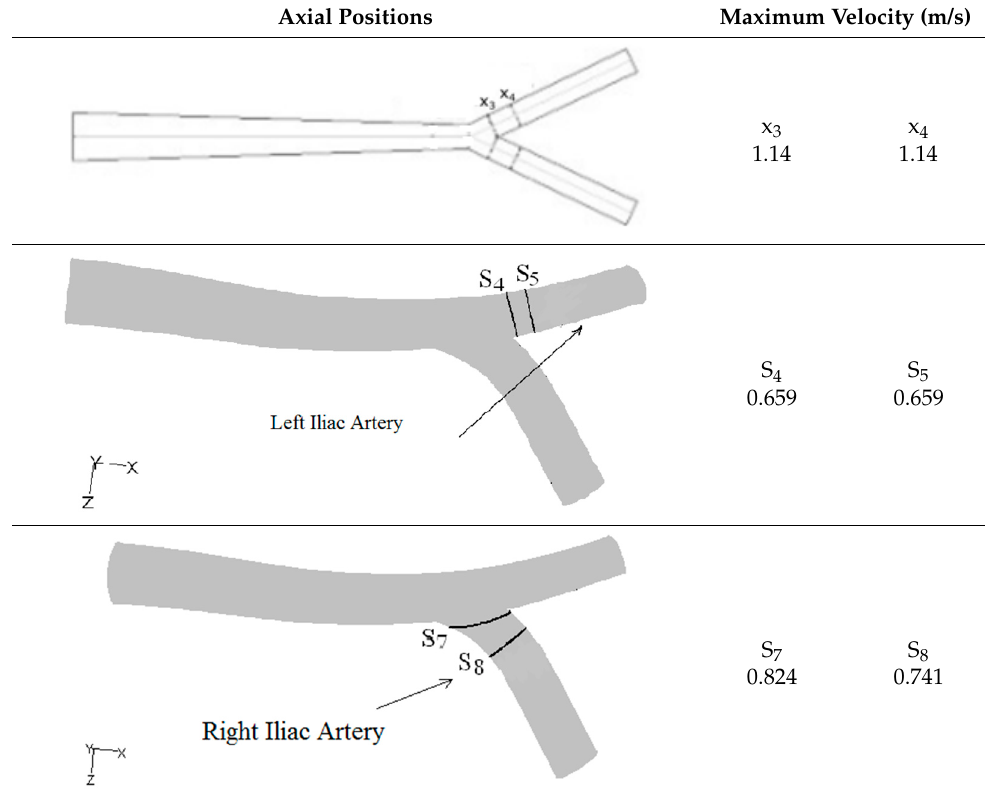
Table 1. Comparison between the velocities measured for the anatomical and idealized model . Axial Positions